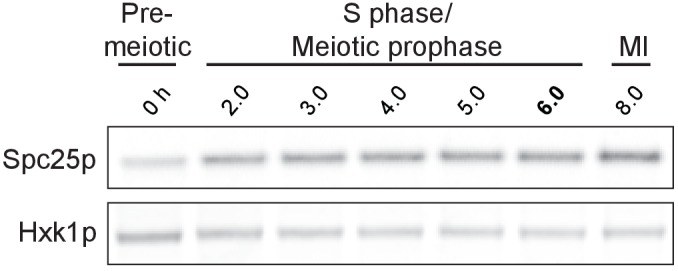
Spc25 protein is present throughout meiotic prophase.Spc25-3V5 was detected by anti-V5 immunoblot. Hxk1, loading control. Cells (UB1051) were transferred to sporulation media (SPO) at 0 hr and arrested in pachytene using the reversible pGAL-NDT80 block. After 6 hr in SPO, NDT80 expression was induced with β-estradiol.